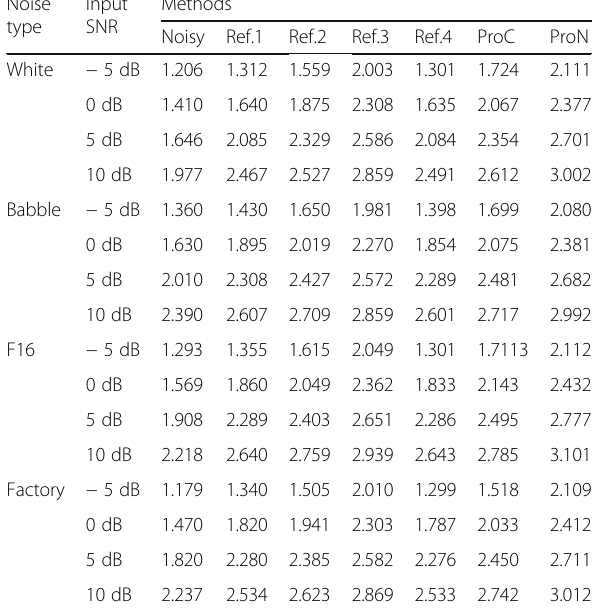
Table 3 Test results of PESQ Noise